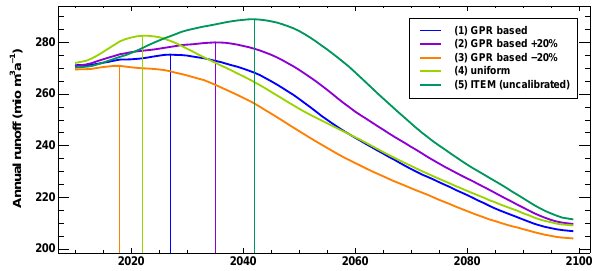
Fig. 12. Runoff projections based on the different initial ice- thickness distributions. The numbers in brackets refer to the dif- ferent initial ice volume distributions presented in Section